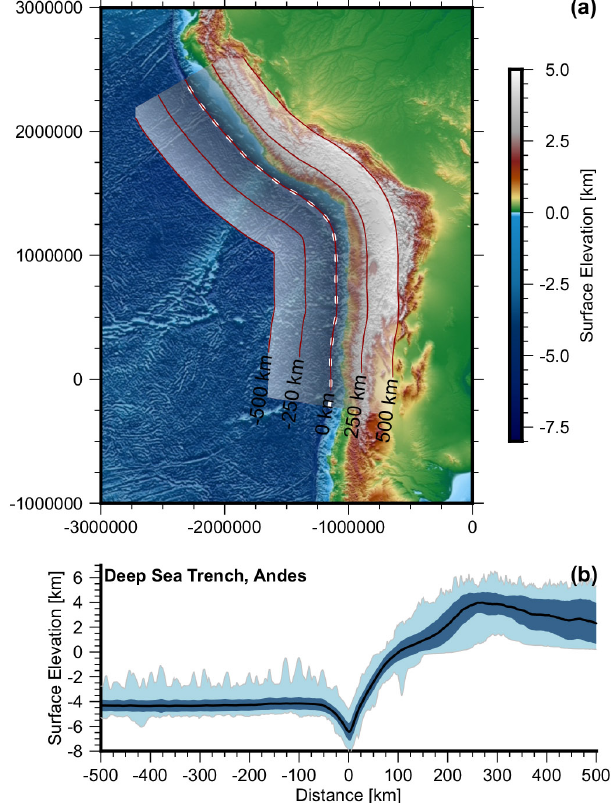
Figure 5. Topographic and bathymetric representation of the con- verging Nazca and South American plates as an example of a curved subduction zone. The baseline of the generalized swath profile fol- lows the trench (white and red dashed line). Red contours indicate the signed distance to the baseline. The pale region covers all values included in the profile. The mean elevation is shown by the black line. Extreme values and mean values ± 1 standard deviation are in- dicated by the light- and dark-blue areas, respectively. Bin width is 1km. Map and profile were derived from the ETOPO1 digital ele- vation model (http: // www.ngdc.noaa.gov / mgg / global / ).